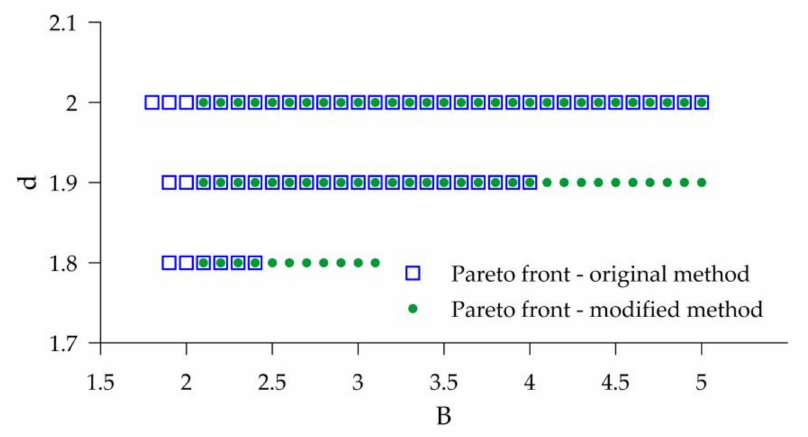
Figure 14. The comparison of Pareto fronts obtained by applying the original and the modified RGD method in the decision space.